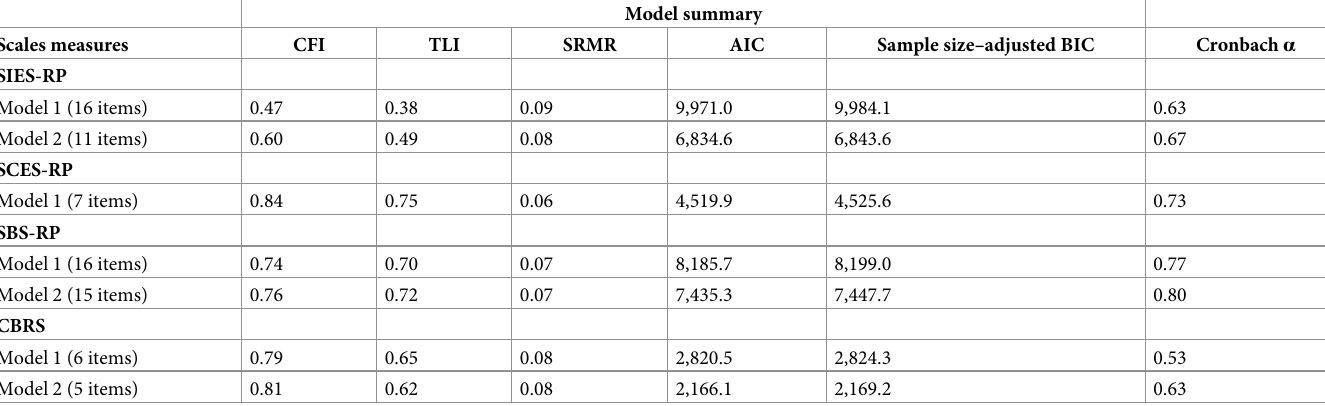
Table 2. Values of CFI, TLI, SRMR, AIC, sample size–adjusted BIC, and Cronbach α for each CFA model with number of items included in CFA.